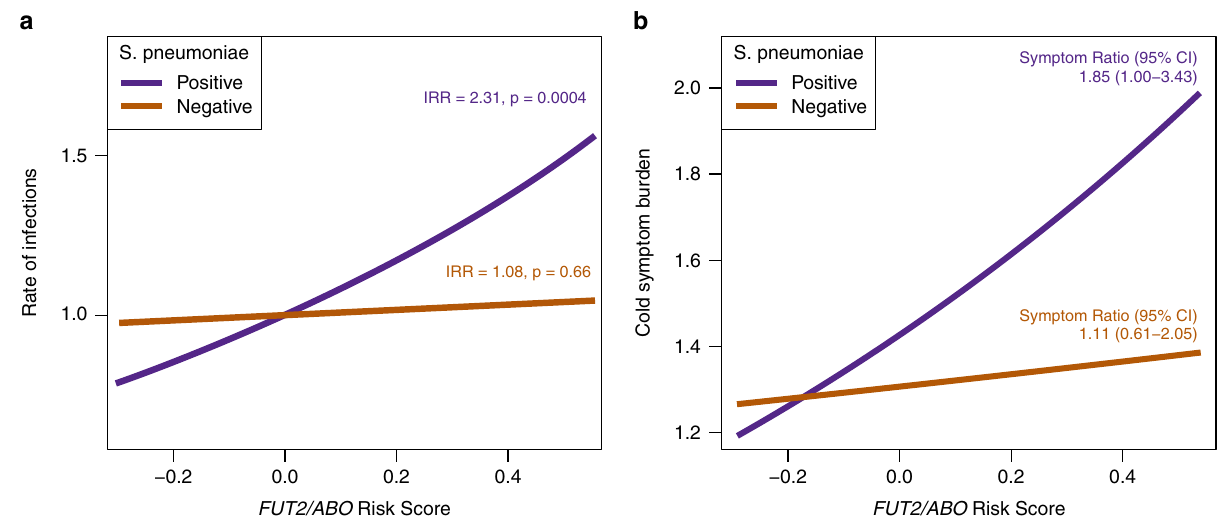
Fig. 5 The effect of the FUT2 – ABO risk score in relation to risk S. pneumoniae and non- S. pneumoniae respiratory illnesses. a illustrates the results in the COPSAC birth cohorts, and b results for the RhinoGen study. Incidence rate ratios in a are estimated using a quasi-Poisson model, which is adjusted for sex and cohort status. Symptom ratios in b are estimated using a mixed-effect quasi-Poison model adjusted for detection of respiratory virus, season, age, sex, race, atopy, and asthma, and a random-effect term for child to account for repeated sampling for each child. a N = 918 and b N = 310. The FUT2 – ABO score was based on rs601338 ( FUT2 ) and rs505922 ( ABO